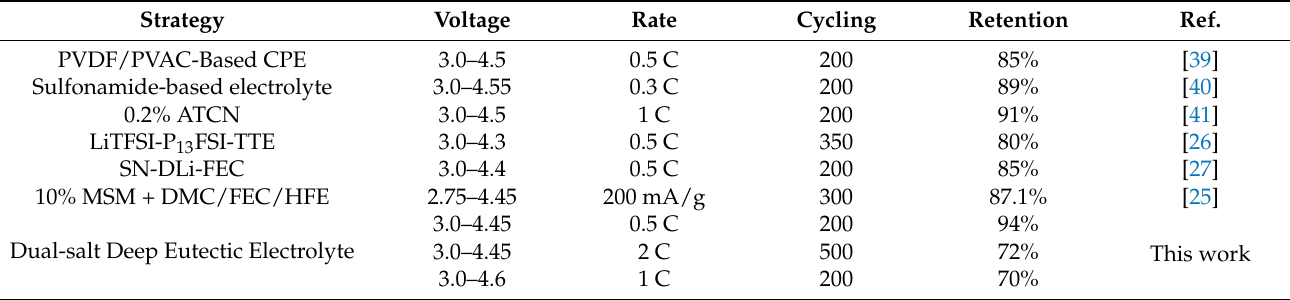
Table 2. A comparison with some previous reports on cycling